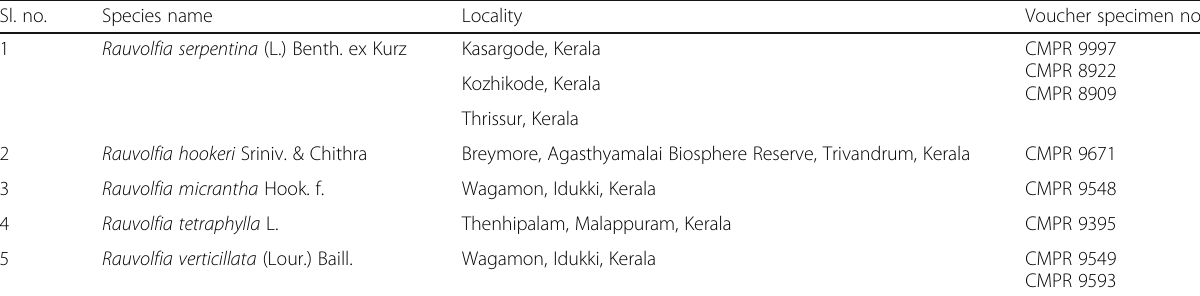
Table 1 Details of plant collections Sl.